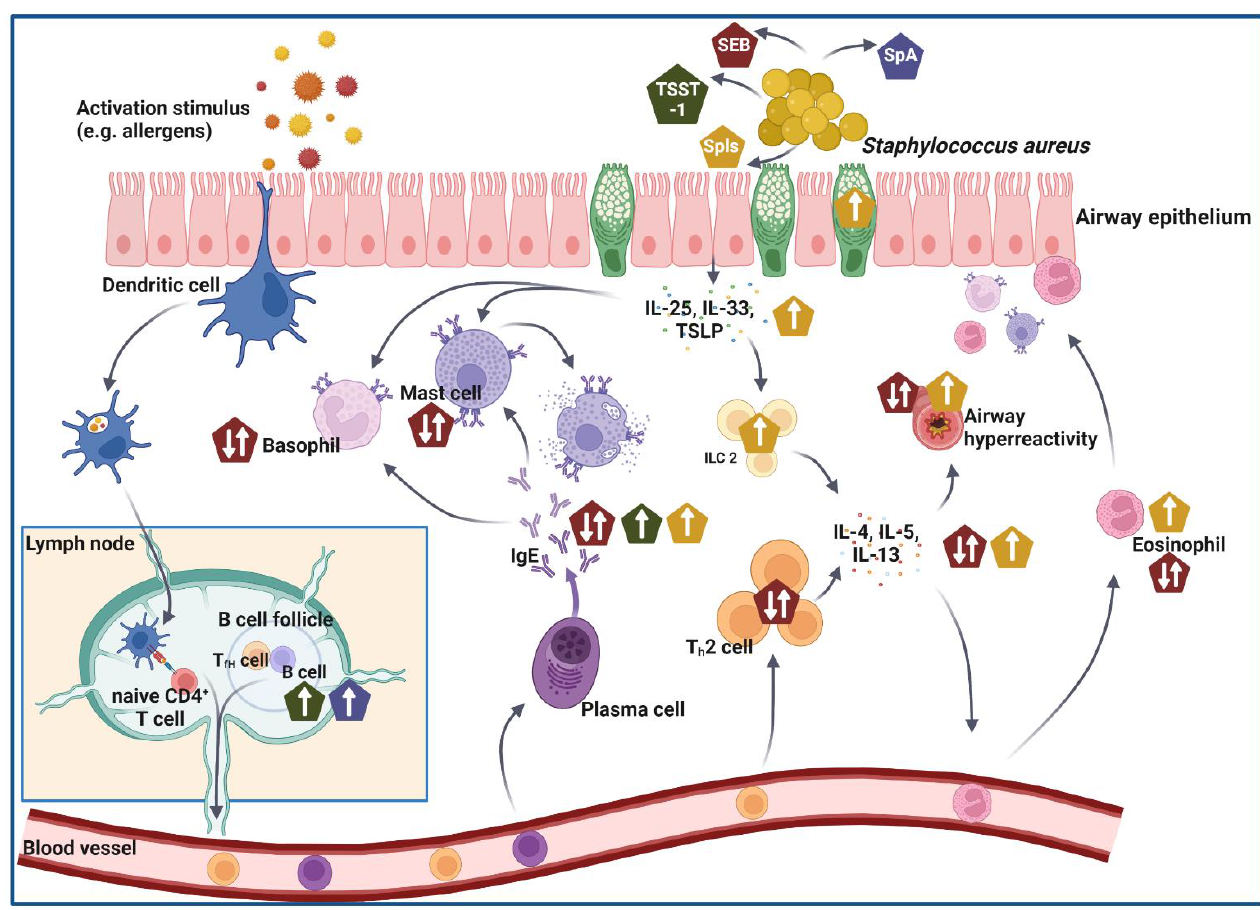
Figure 2. Processes in the pathogenesis of allergic asthma affected by different toxins produced by S. aureus . S. aureus is known for its ability to produce a variety of proteins, including several toxins. Belonging to the family of superantigens produced by S. aureus , the toxic shock syndrome toxin-1 (TSST-1; green pentagon) mainly affects B cell immunity by enhancing the number of B cells and thereby the amount of produced IgE antibodies (indicated by white arrows in green pentagons). Another member of the superantigen family, the S. aureus enterotoxin B (SEB; red pentagon) is presumably able to affect pathogenesis in multiple ways. In human studies, asthmatic individuals showed increased SEB-specific IgE-levels, as well as stronger asthmatic symptoms. In murine studies, it has been shown that intranasal SEB-administration can have either ameliorating or aggravating effects on allergic airway inflammation and affects various key effector cells and mediators involved in pathogenesis. White arrows in red pentagons indicate SEB-mediated effects. Serine-protease-like proteases (Spls; yellow pentagon) are a family of six proteases produced by S. aureus , which could also affect the pathogenesis of allergic asthma. In asthmatic patients, significantly higher Spl-specific IgE-levels have been observed, and in a murine study, it has been shown that SplD is especially able to induce an asthma-like phenotype after intratracheal administration (indicated by white arrows in yellow pentagons). The S. aureus protein A (SpA; blue pentagons) is referred to as a B cell superantigen, and in atopic patients, it triggers strong B cell proliferation and increased production of IgE antibodies. Those effects mediated by SpA are indicated through white arrows in blue